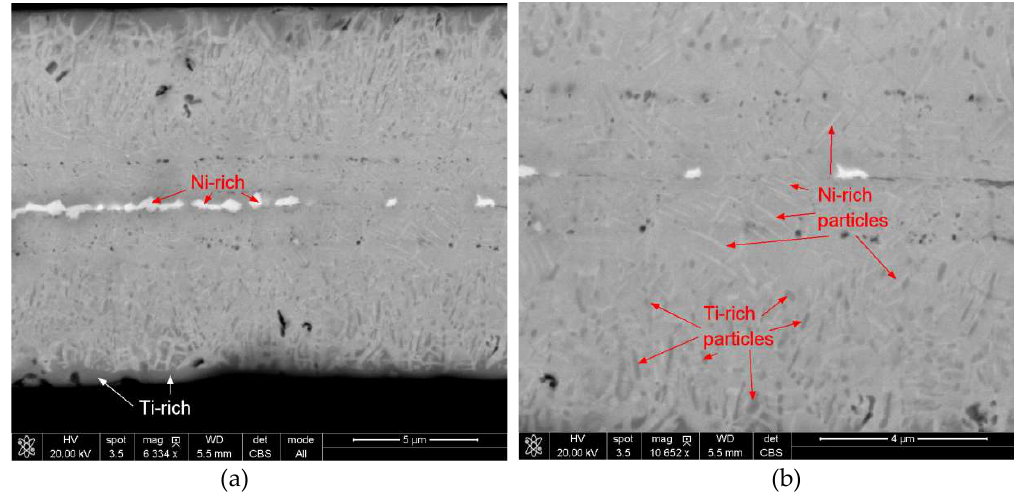
Figure 5. Back scattering electron-image results for the cross-sections of sample ST3: ( a ) whole cross-section and ( b ) zoomed area. Images taken at different parts of the micro-foil cross-sections.